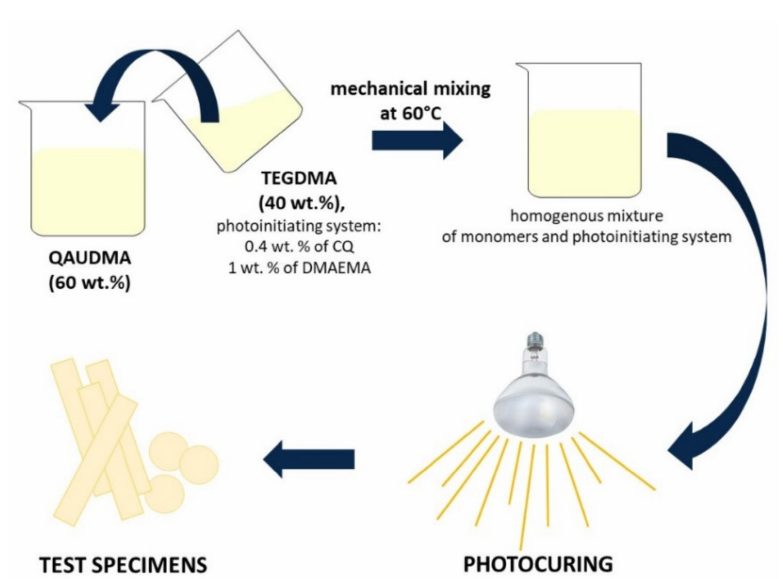
Figure 2. Sample